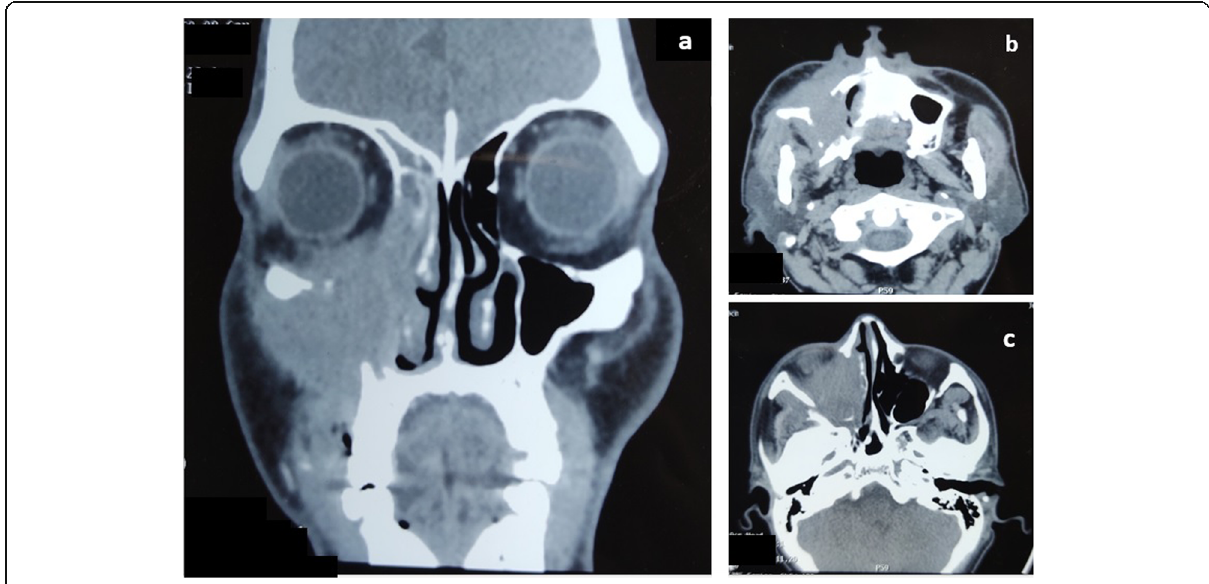
Fig. 1 CECT scan showing right maxillary tumor with a extension to orbit (sagittal view), b anterior and posterolateral extension (axial view), and c meatus involvement and intraorbital invasion (axial